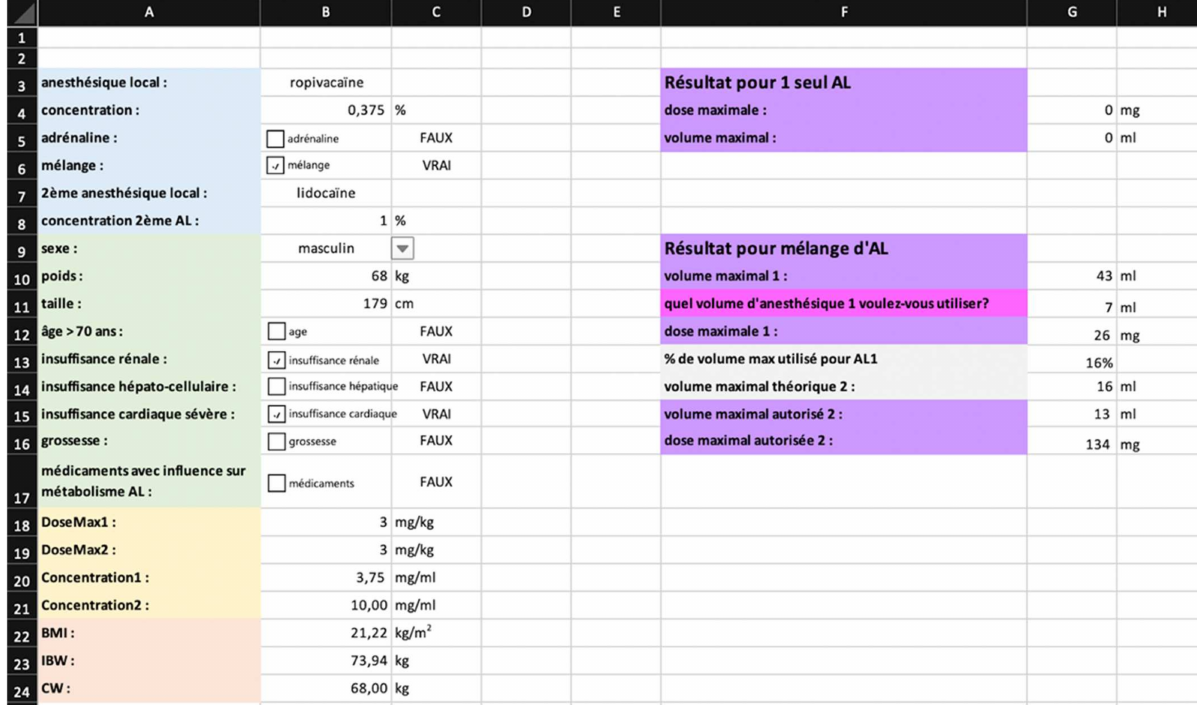
Figure 3. First (low fidelity) prototype developed under Microsoft